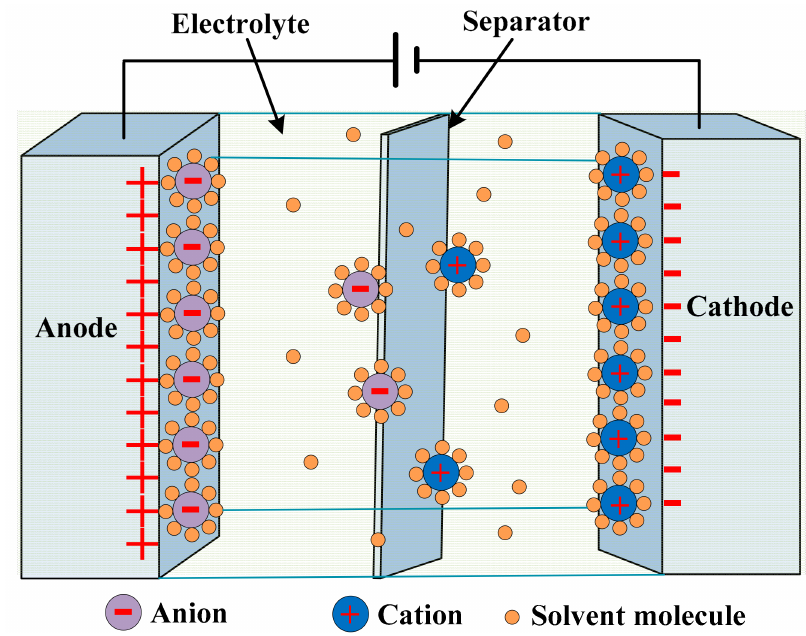
Figure 11. Capacitor as storage device in micro-energy harvesting. Table 4. Comparison between batteries and capacitor considering temperature, charging/discharging time, and